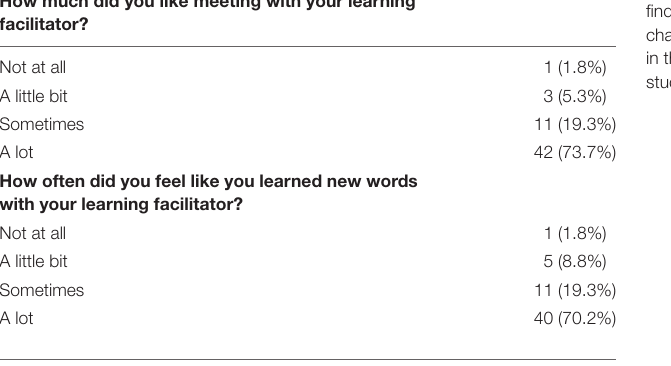
TABLE 7 | Caregiver experiences in scaffolding group.